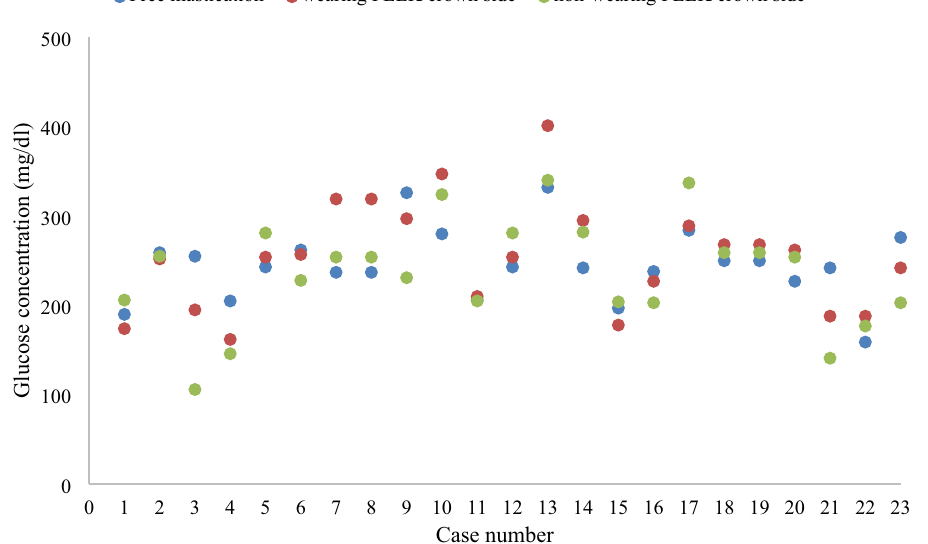
Figure 5. Distribution for the 23 cases of Glucose concentration by masticatory ability test focused on the mounting side of the PEEK crown. *Classified by wearing PEEK crowns side and non-wearing PEEK crowns sides.